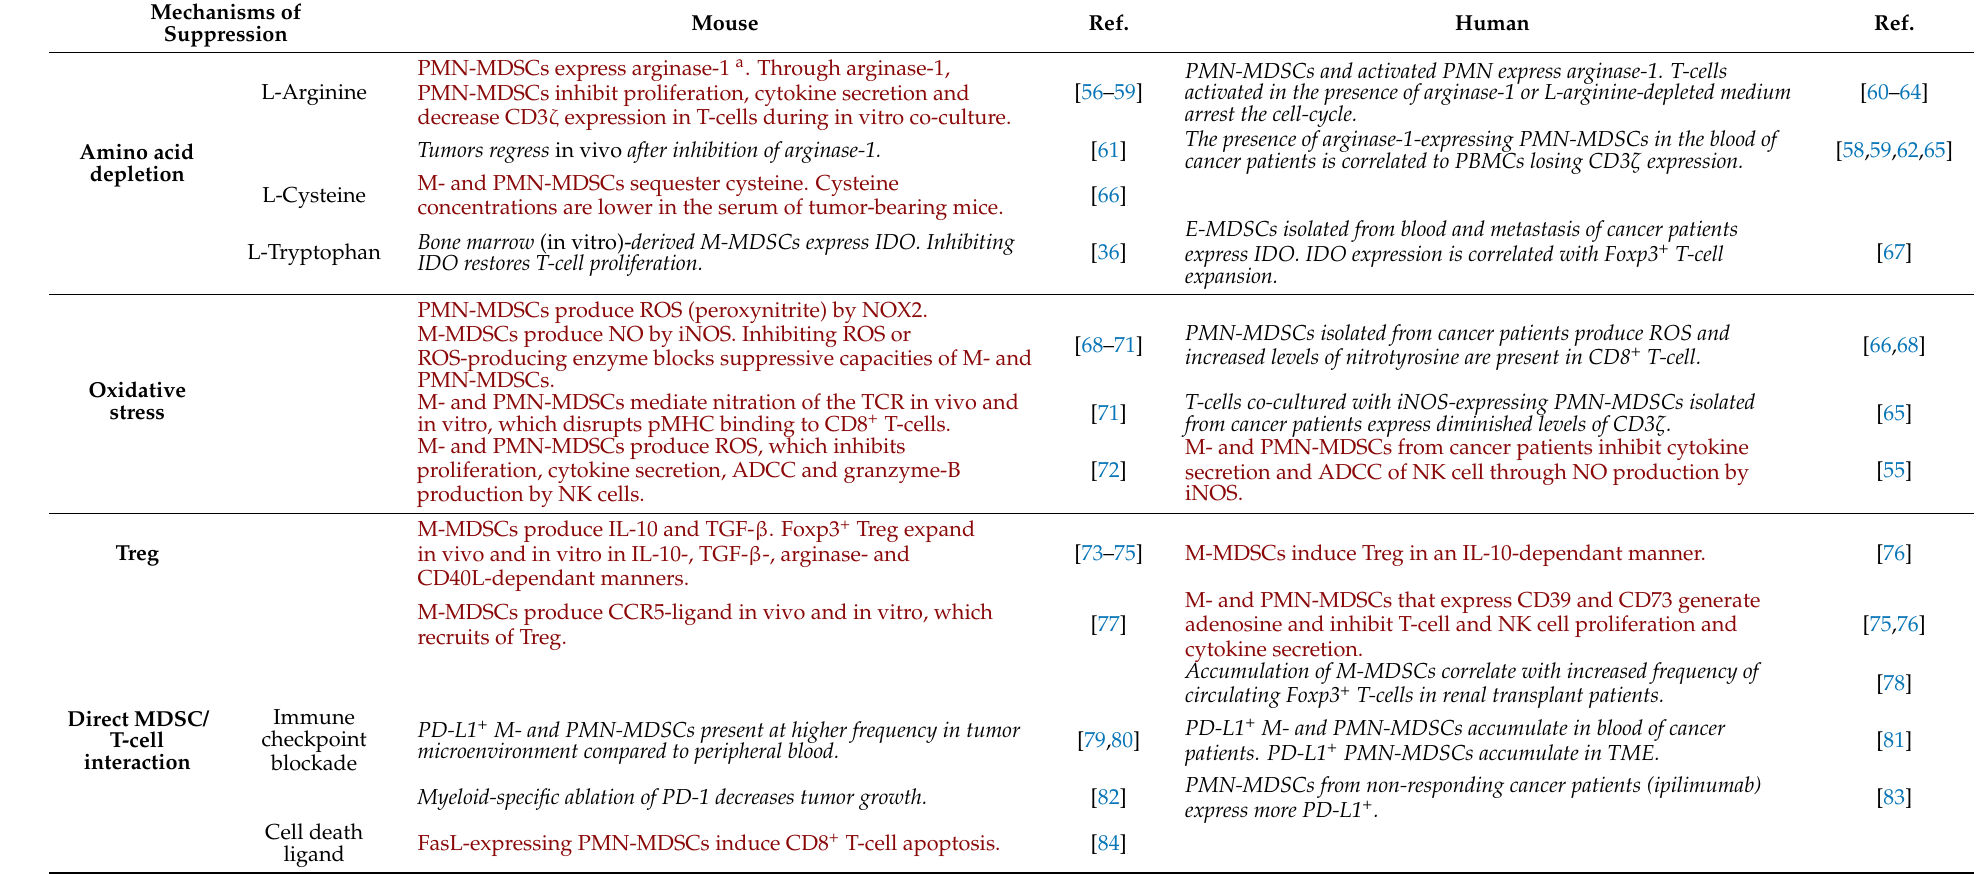
Table 1. Summary of immunosuppressive mechanisms related to